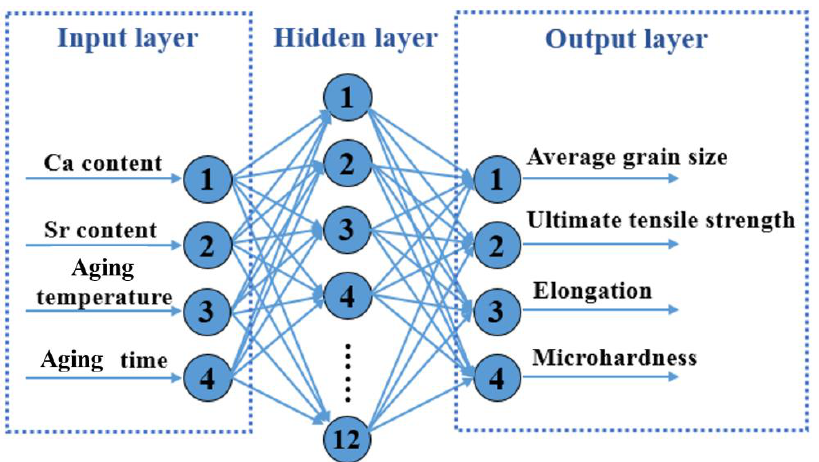
Figure 4. The network configuration of the ANN model.